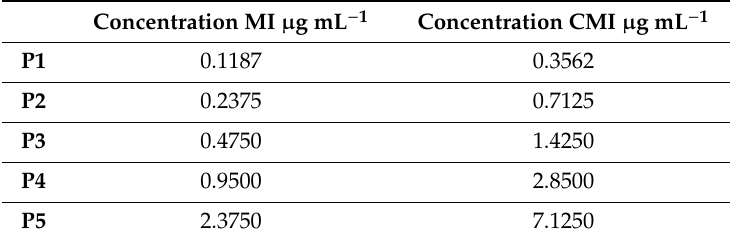
Table 1. ProClin TM 150 standards preparation for the calibration